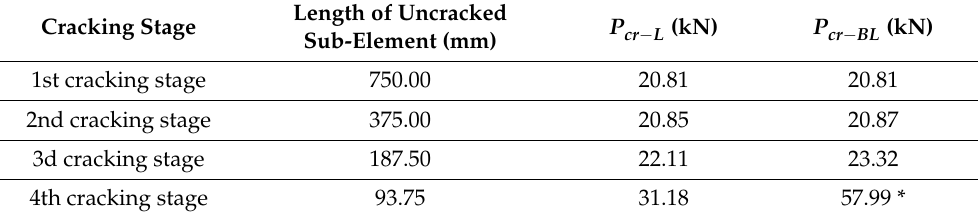
Table 1. Cracking Table 1. Cracking forces.